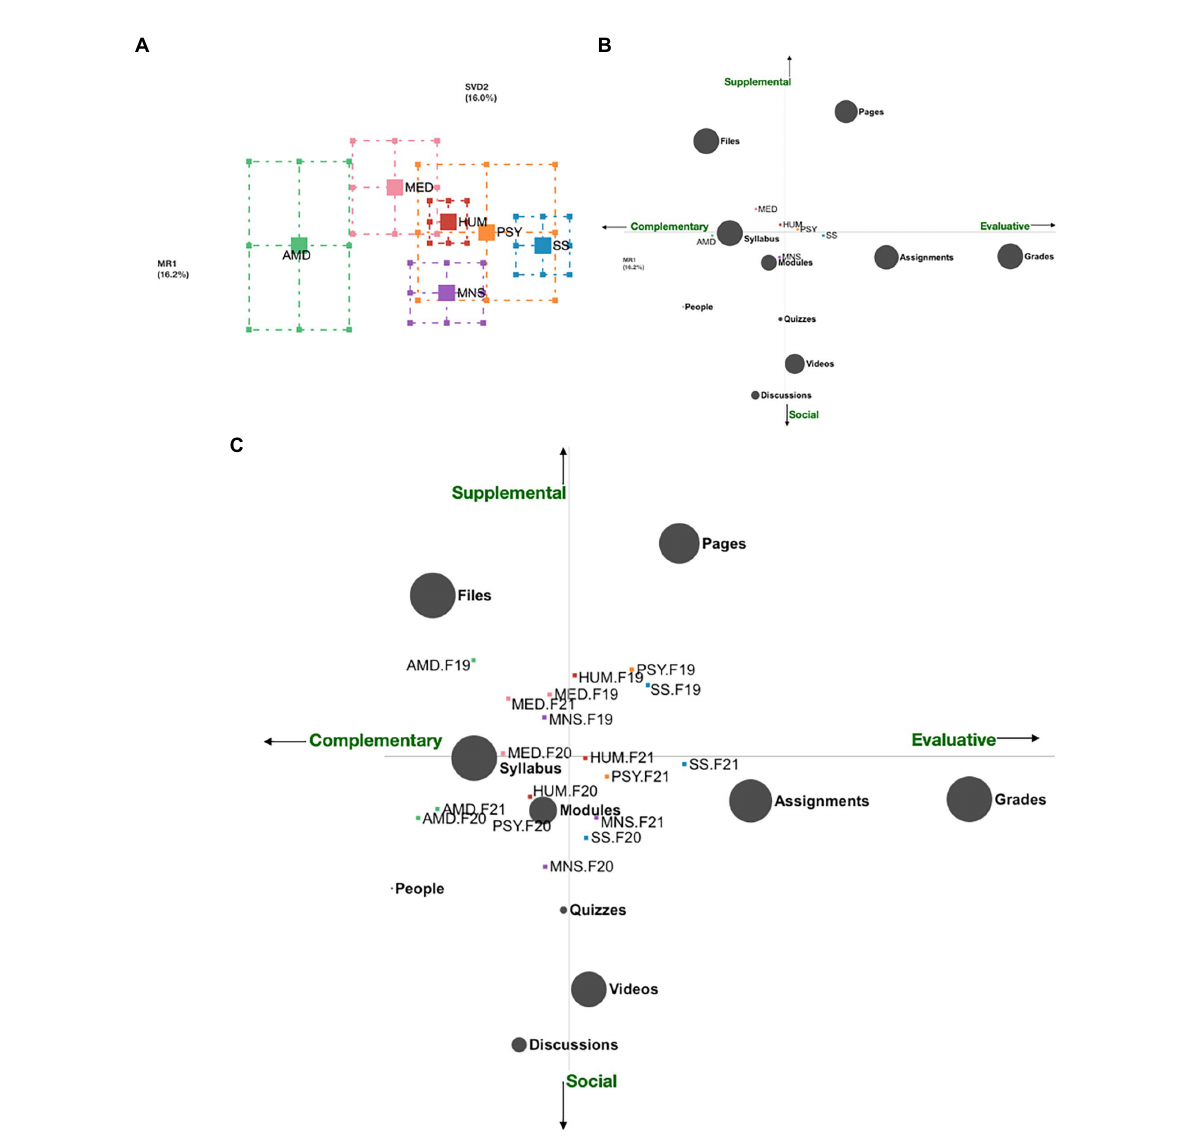
FIGURE 5 (A) Faculty network means with confidence intervals projected to the ENA space (green: AMD, pink: MED, red: HUM, purple: MNS, orange: PSY, blue: SS); (B) ENA network means of faculty learning designs with the mapping of the course types along the x and y axes (green: AMD, pink: MED, red: HUM, purple: MNS, orange: PSY, blue: SS); (C) ENA network means of faculty learning designs by semester with the mapping of the course types along the x and y axes (green: AMD, pink: MED, red: HUM, purple: MNS, orange: PSY, blue: